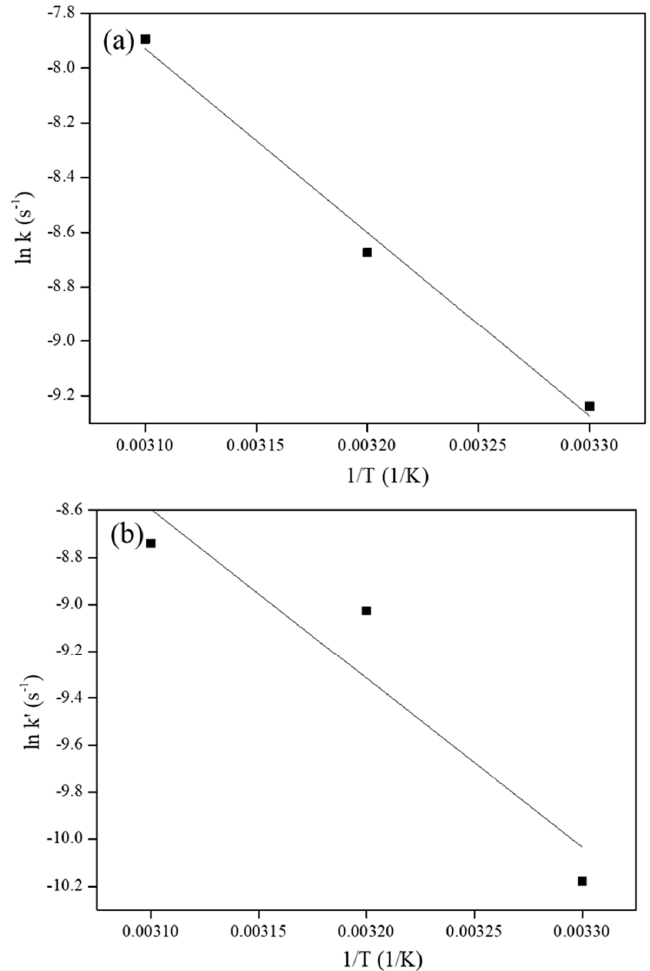
Figure 4. Plot of ( a ) ln k vs. 1/T (for hydrogenation yield) and ( b ) ln k’ vs. 1/T (for epoxy ring